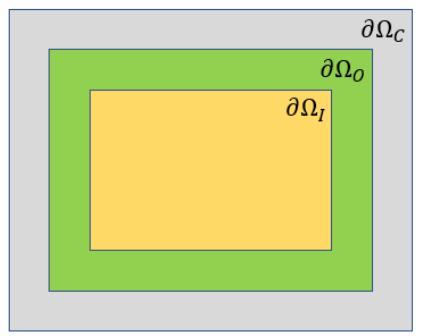
Figure 6. Extensions for the different areas ∂ Ω C of computation, ∂ Ω O of observations, and ∂ Ω I of